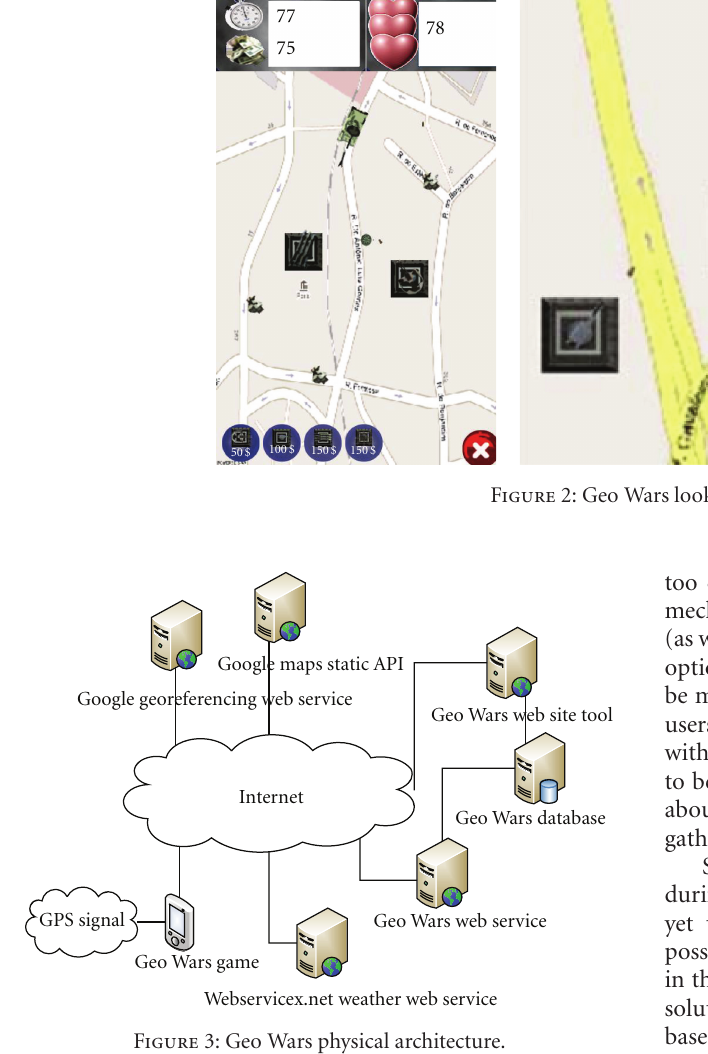
Figure 3: Geo Wars physical